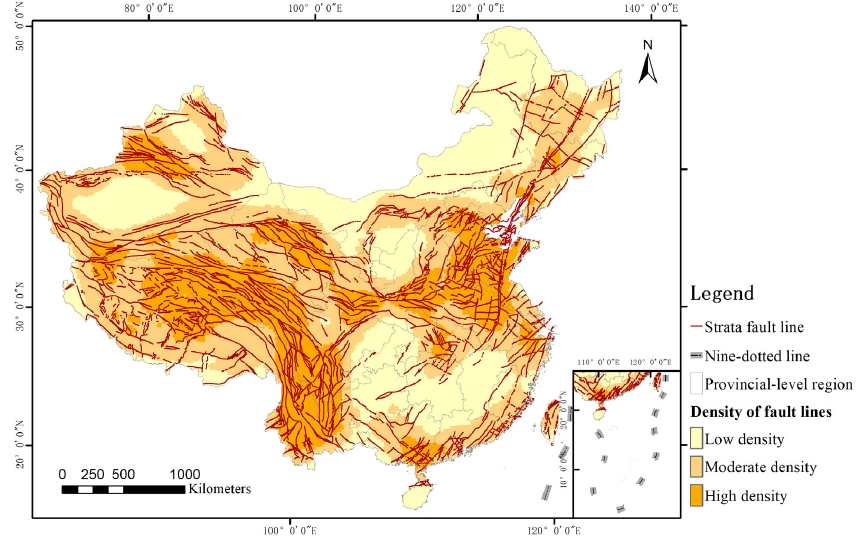
Figure 8. Distribution of the classified strata fault densities in China’s